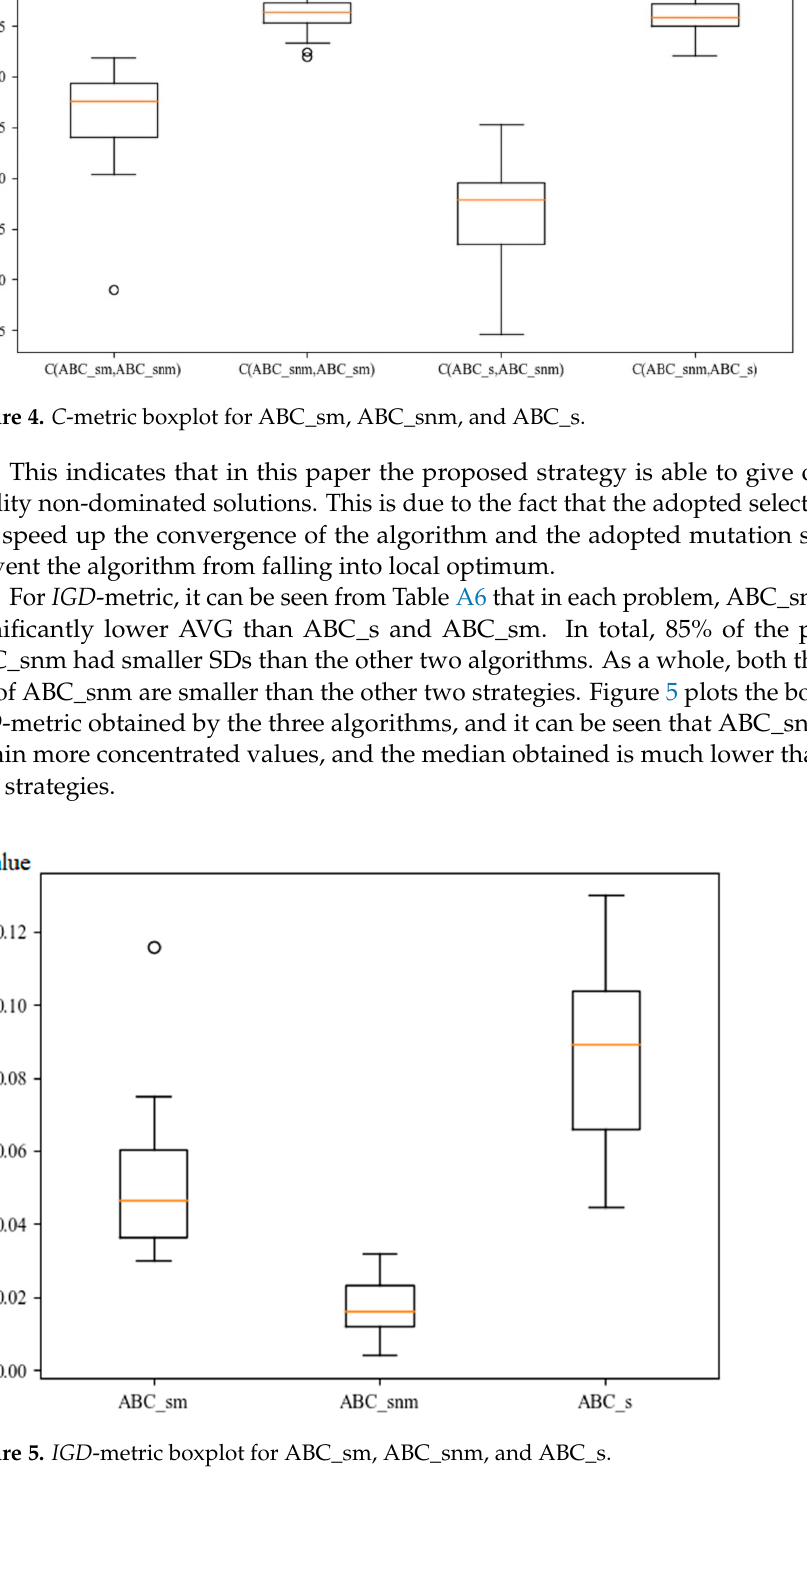
Figure 5. IGD -metric boxplot for ABC_sm, ABC_snm, and ABC_s.